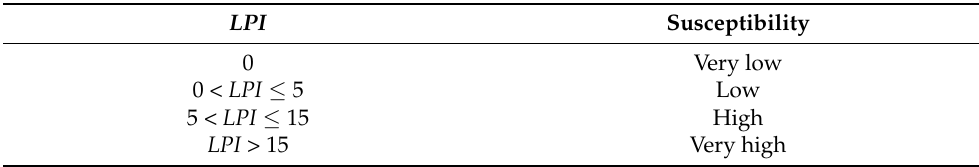
Table 2. Liquefaction potential classification (Adapted from ref. [59]).